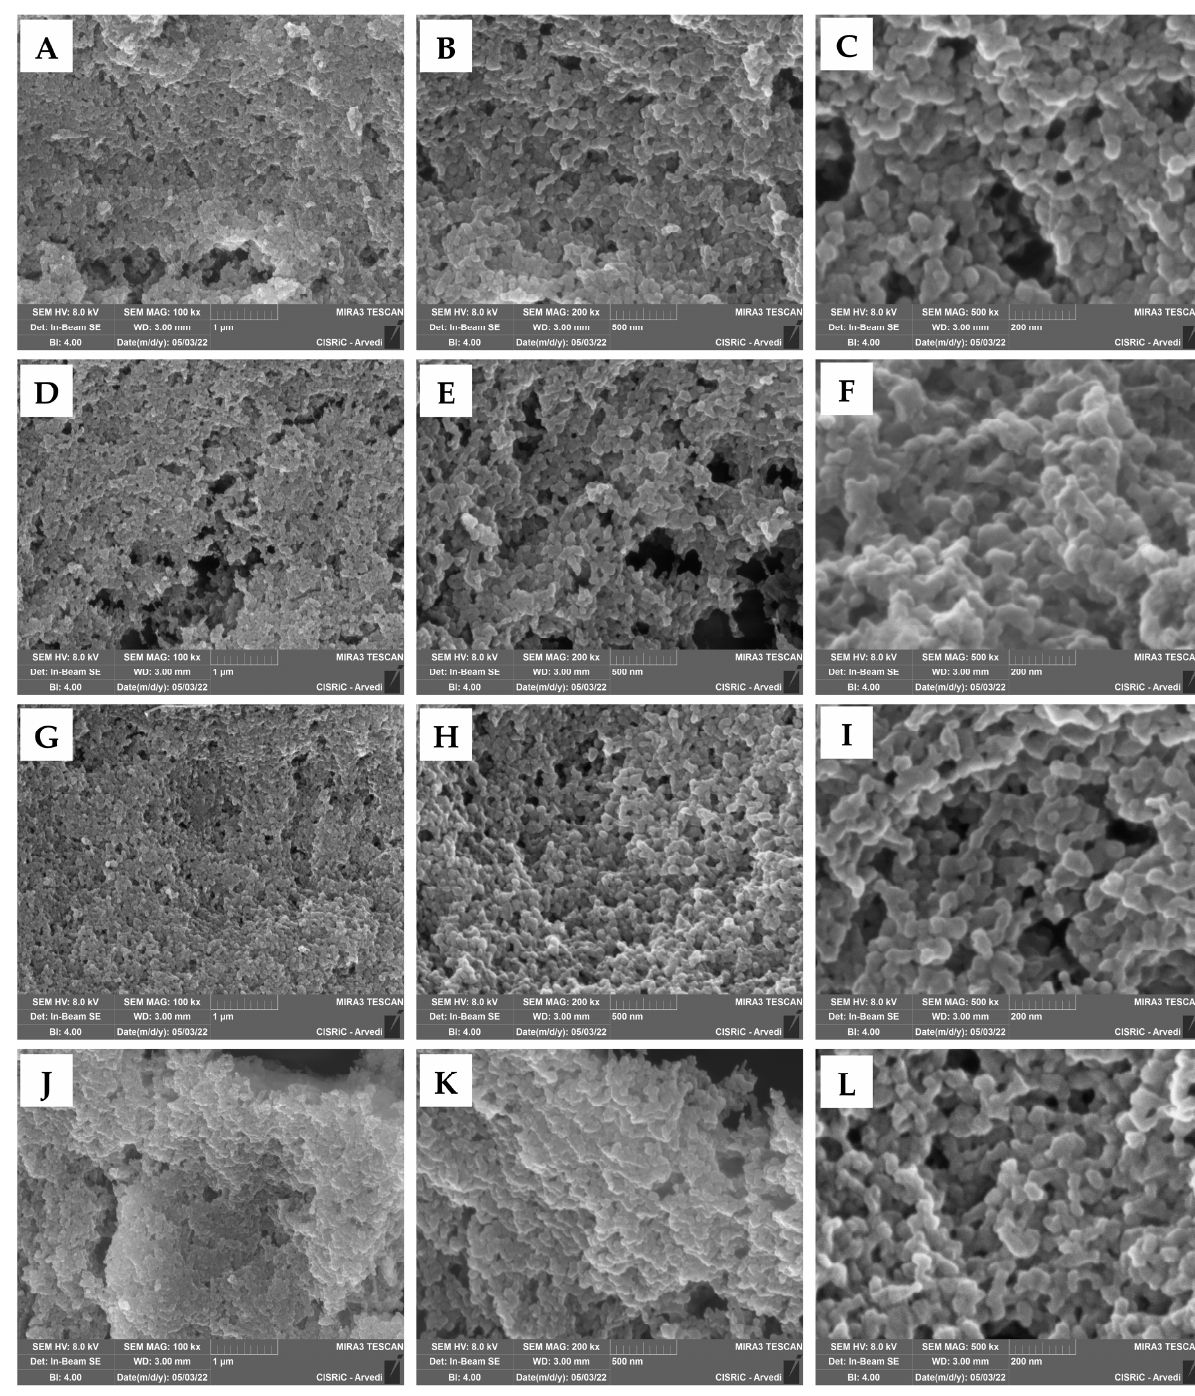
Figure 1. Morphological investigation by SEM of SFNs ( A – C ), SFNs-NDI-1 ( D – F ), c RGD-SFNs ( G – I ), and c RGD-SFNs-NDI-1 ( J – L ). Magnification: 100k× ( A , D , G , J ), 200k× ( B , E , H , K ), and 500k× ( C , F , I , L ). Scale bar: 1 µm ( A , D , G , J ), 500 nm ( B , E , H , K ), and 200 nm ( C , F , I , L ).